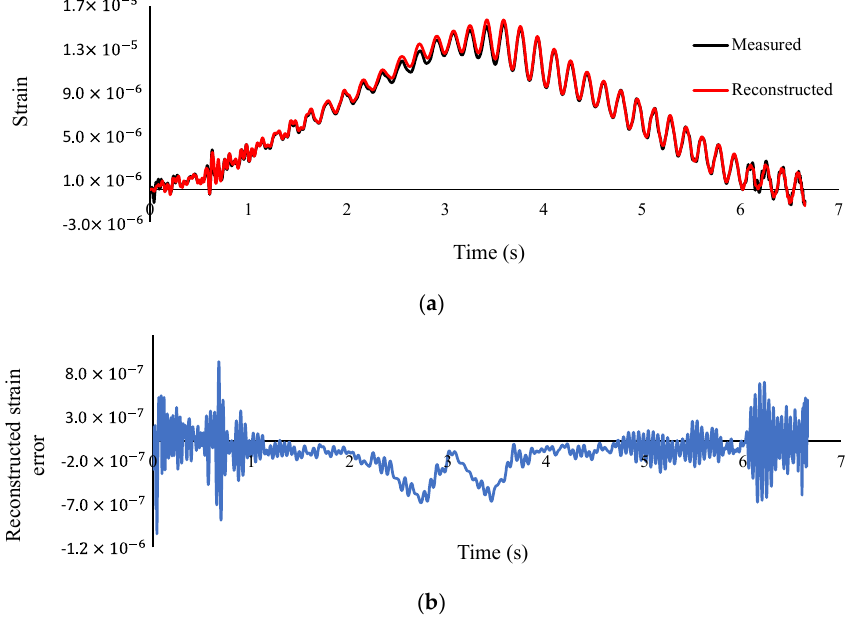
Figure 16. ( a ) Measured and reconstructed strain at mid-span ( b ) Error of reconstructed strain (Damage case 1—speed 0.47 m/s—sampling frequency 800 Hz).